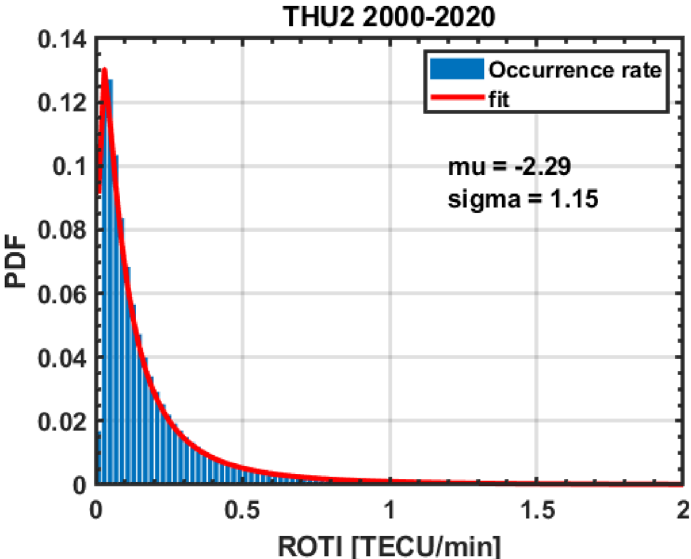
Fig. 12. The occurrence rate of ROTI during 2000 – 2020. The probability density function (PDF) is fi tted with lognormal distribution by the red line. The fi tted parameters are also